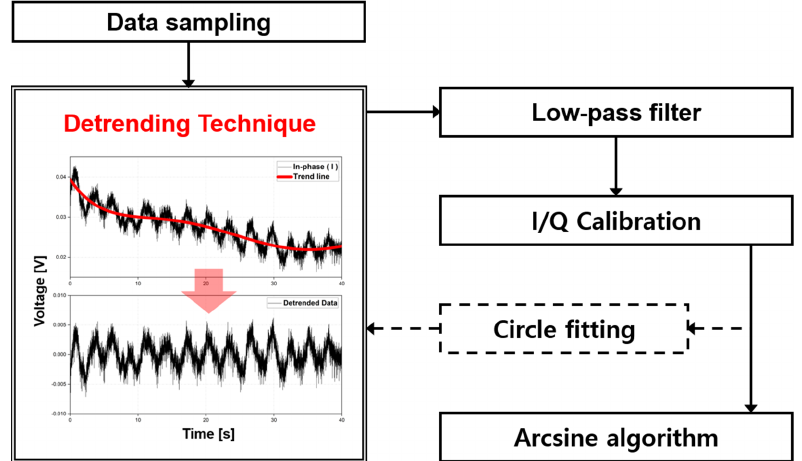
Figure 4. Overall flow chart for the digital signal processing, including the proposed detrending technique for the phase extraction of the CW radar.